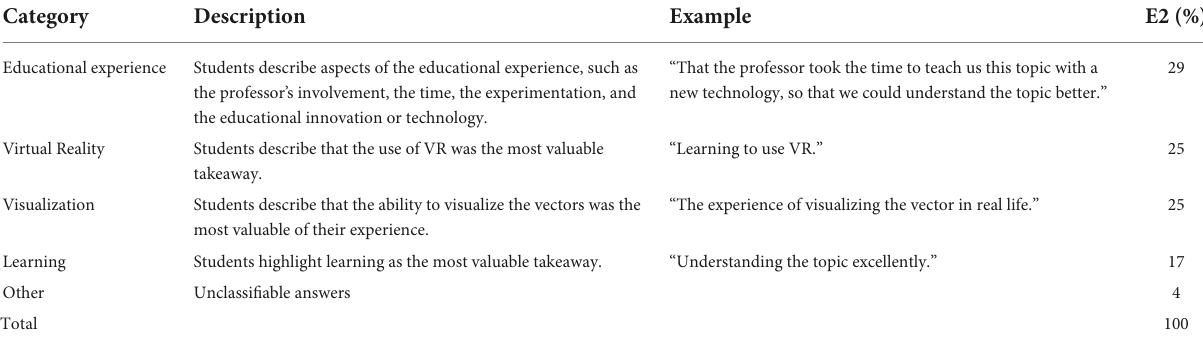
TABLE 6 Description of categories for question E2: “I think the most valuable of this experience was.” Category Description Educational